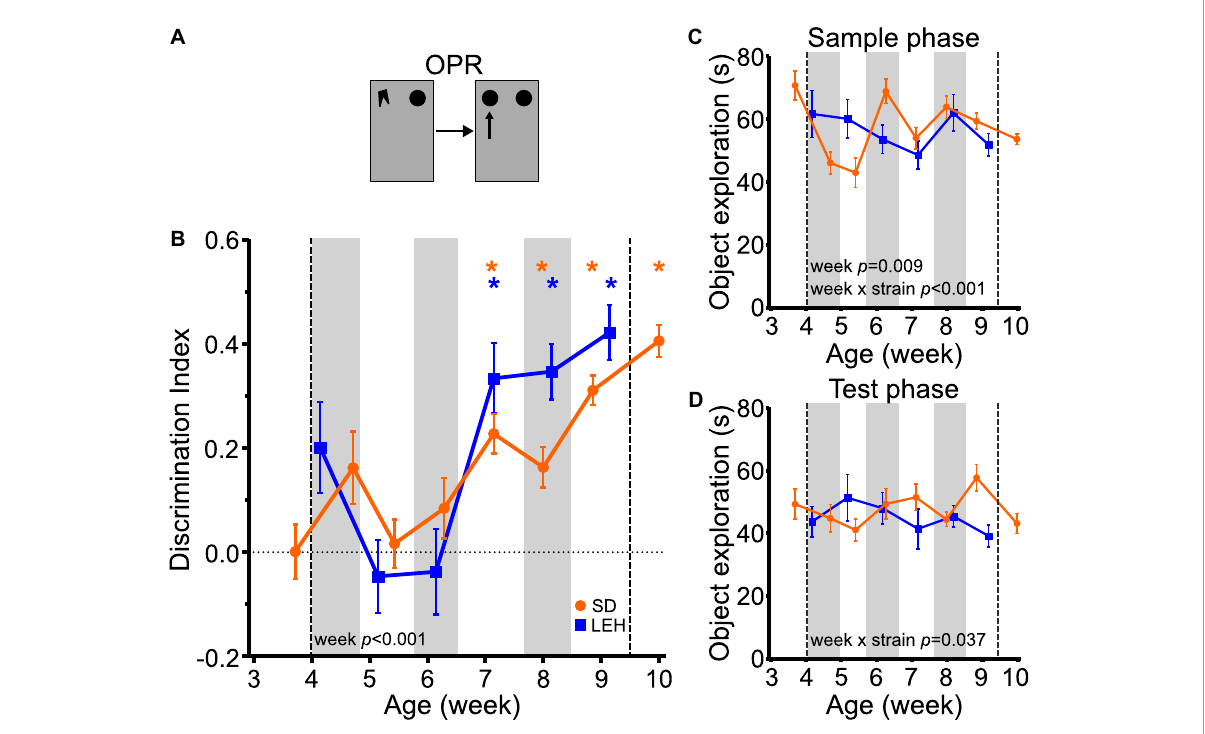
FIGURE4 Object-place recognition memory emerges at around 7 weeks of age in LEH and SD rats. (A) Schematic of object-place recognition task; (B) Object-place recognition memory performance, expressed as discrimination index across development. Both LEH and SD rats show significant memory consistently from the 7th week of age (P50 for both LEH and SD). * p < 0.05. A significant main effect of week was found; (C) Object exploration during the sample and test phases for each testing time point for both LEH and SD rats. A significant main effect of week as well as a significant week × strain interaction were detected; (D) Object exploration during the test phase. A significant week × strain interaction was found. [SD]: n = 16 for all time points; [LEH]: n = 13 except P50 where n = 12. For details on sample sizes, t , and p values for one-sample t -tests, see Supplementary Table 2 . Asterisks, shading on graphs etc., follow same convention as Figure 2